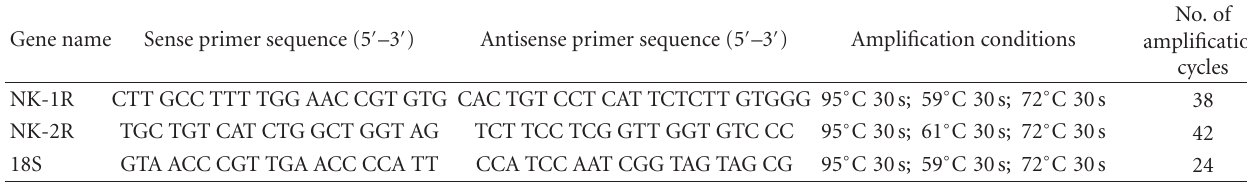
Table 1: Primer sequences and optimal conditions used in PCR